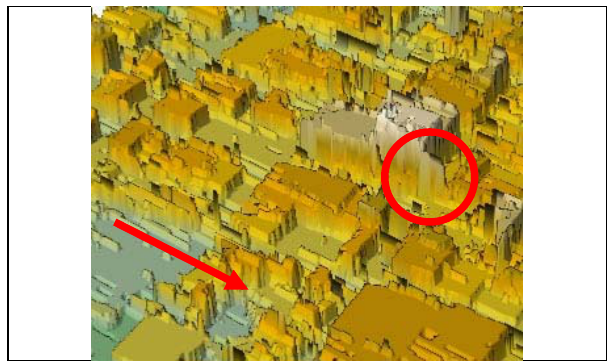
Figure 9: DSM by matching with DP without filtering, arrow = epipolar line direction